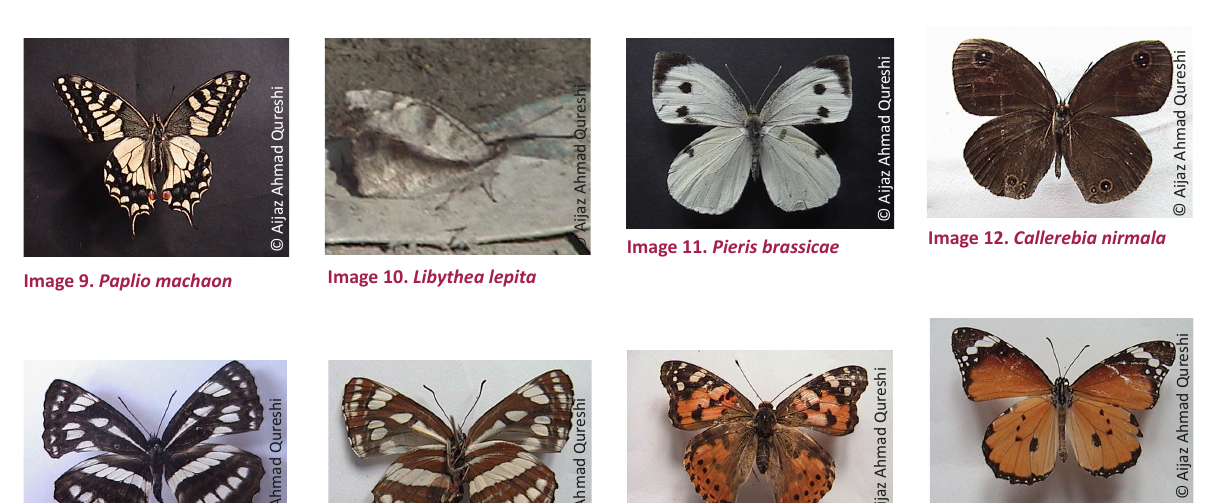
Image 15. Vanessa cardui